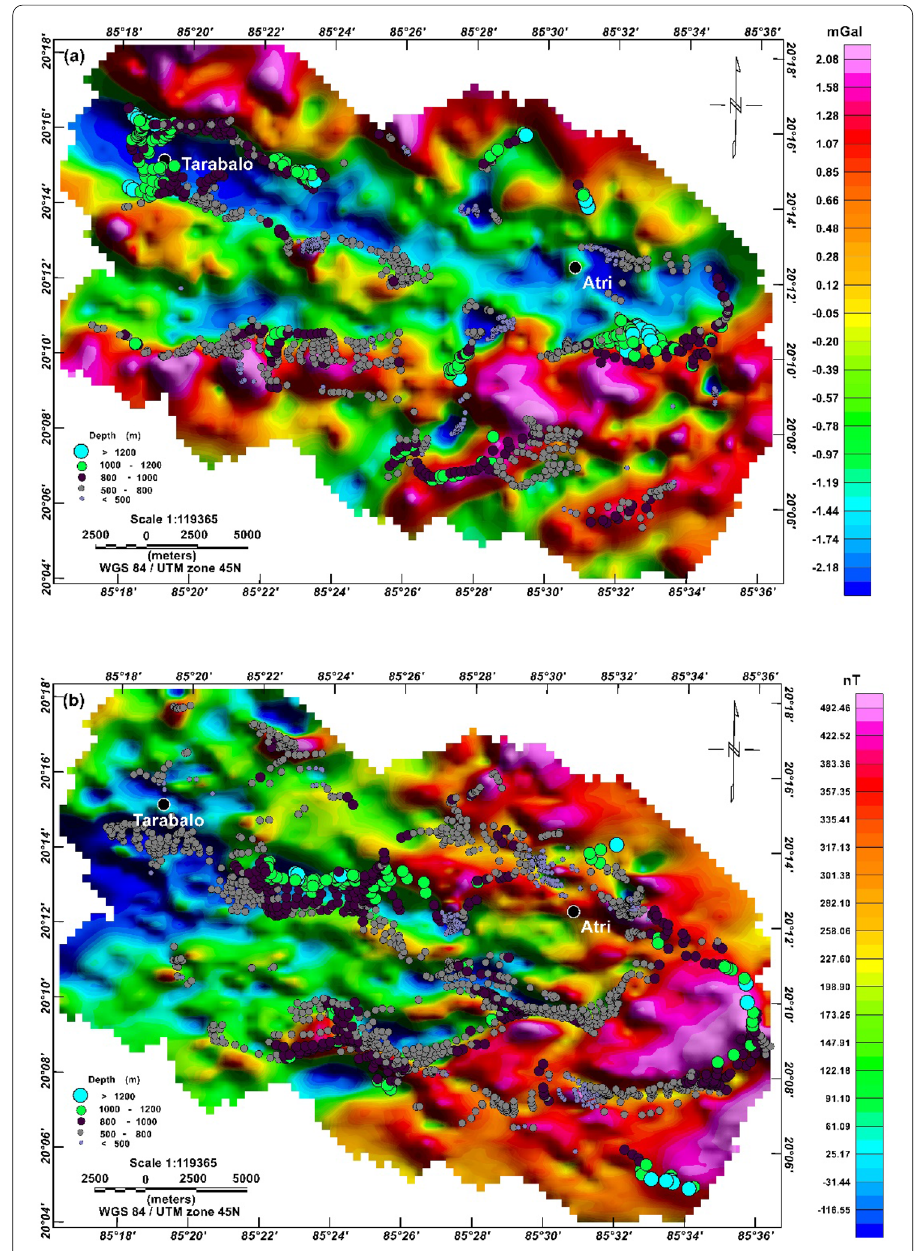
Fig. 5 Euler depth solutions of a residual Bouguer gravity data sets using structural index field magnetic data using structural index